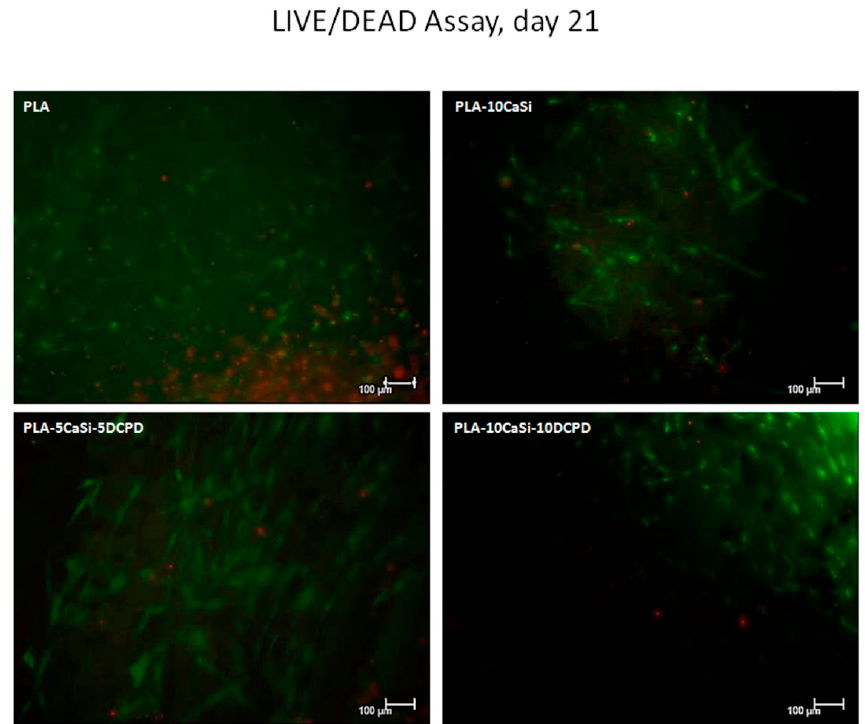
Figure 10. Live/dead assay. Live/dead staining, at day 14 of culture, in order to detect viable (green) and non-viable (red) hPCy-MSCs within the tested scaffolds (CLSM, 10× magnification). Materials 2019 , 12 , x FOR PEER REVIEW